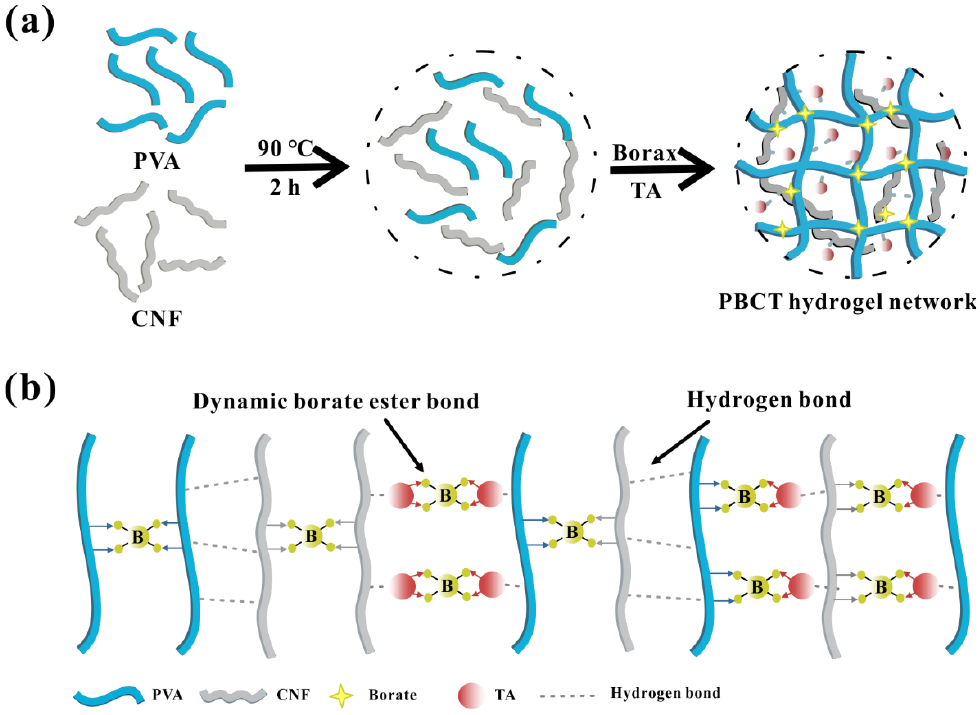
Figure 4. Scheme for synthesis of tannic acid-polyvinyl alcohol-cellulose composite hydrogel ( a ) and the chemical bond diagram in the hydrogel ( b ) (reprinted from reference [170] with permission from Elsevier).